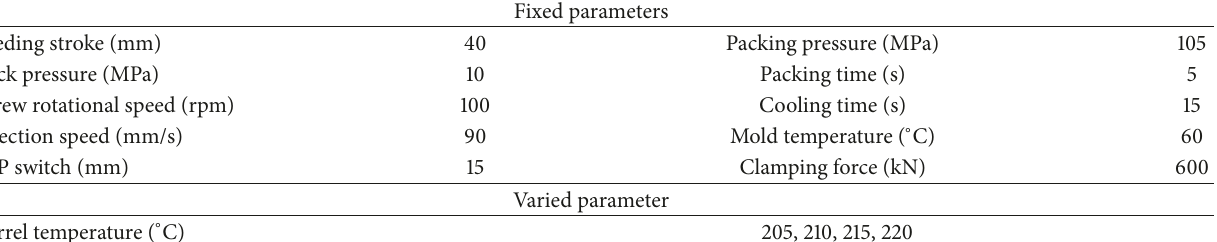
Table 7: Process parameter settings for varied barrel temperature experiments.